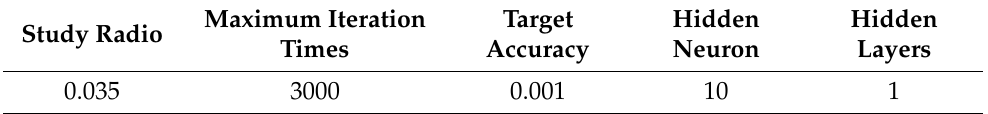
Table 2. Parameters of BP neural network.